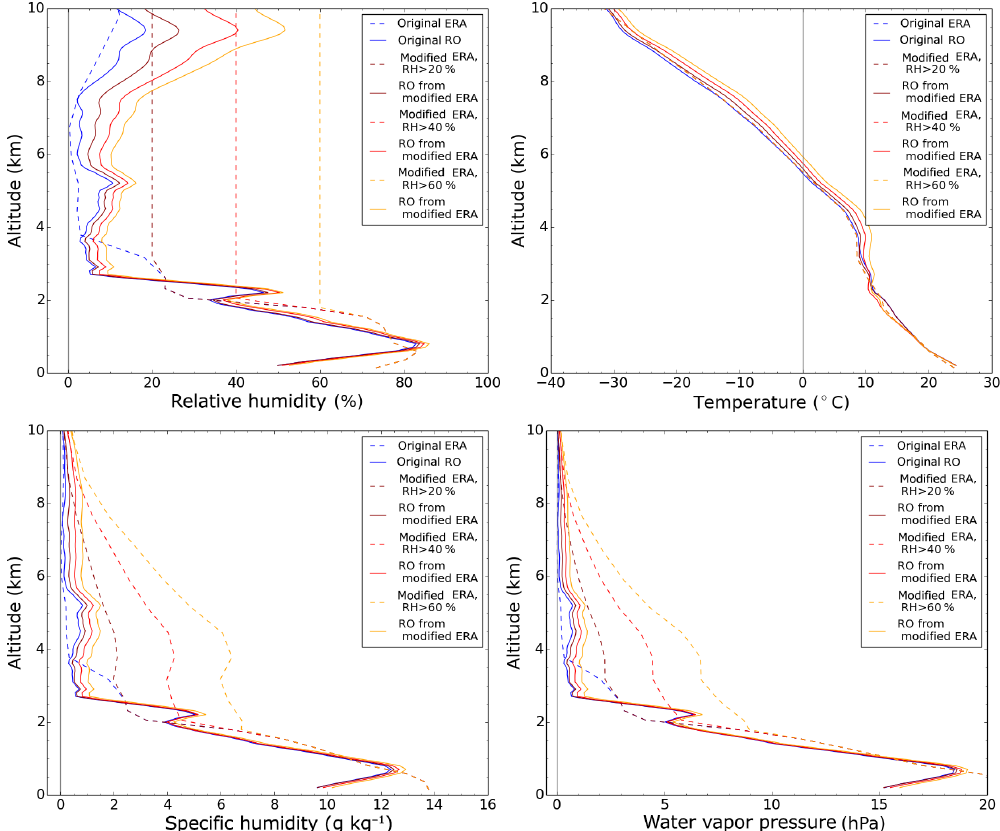
Figure B1. RH, T , q , and e profiles with the original ERA first guess (dashed blue), the original 1D-Var output (solid blue), the “high moisture” first guess (dashed, shades of red), and the 1D-Var output for the modified first guess (solid, shades of